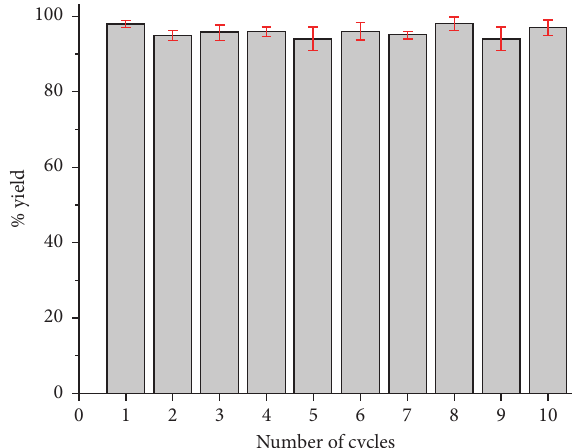
Figure 23: Reuse of Fe 3 O 4 @SiO 2 @LEuH@PW 10 catalyst for the conversion of phenol to bromophenol blue. The experimental conditions included 10ml of 1.0 mM phenol red +10ml of 10.0mM NH 4 Br+0.5g of catalyst+2.5mM H 2 O 2 , in a round-bottomed flask. Time � 10 minutes, T � 298K, and P � 1atm.